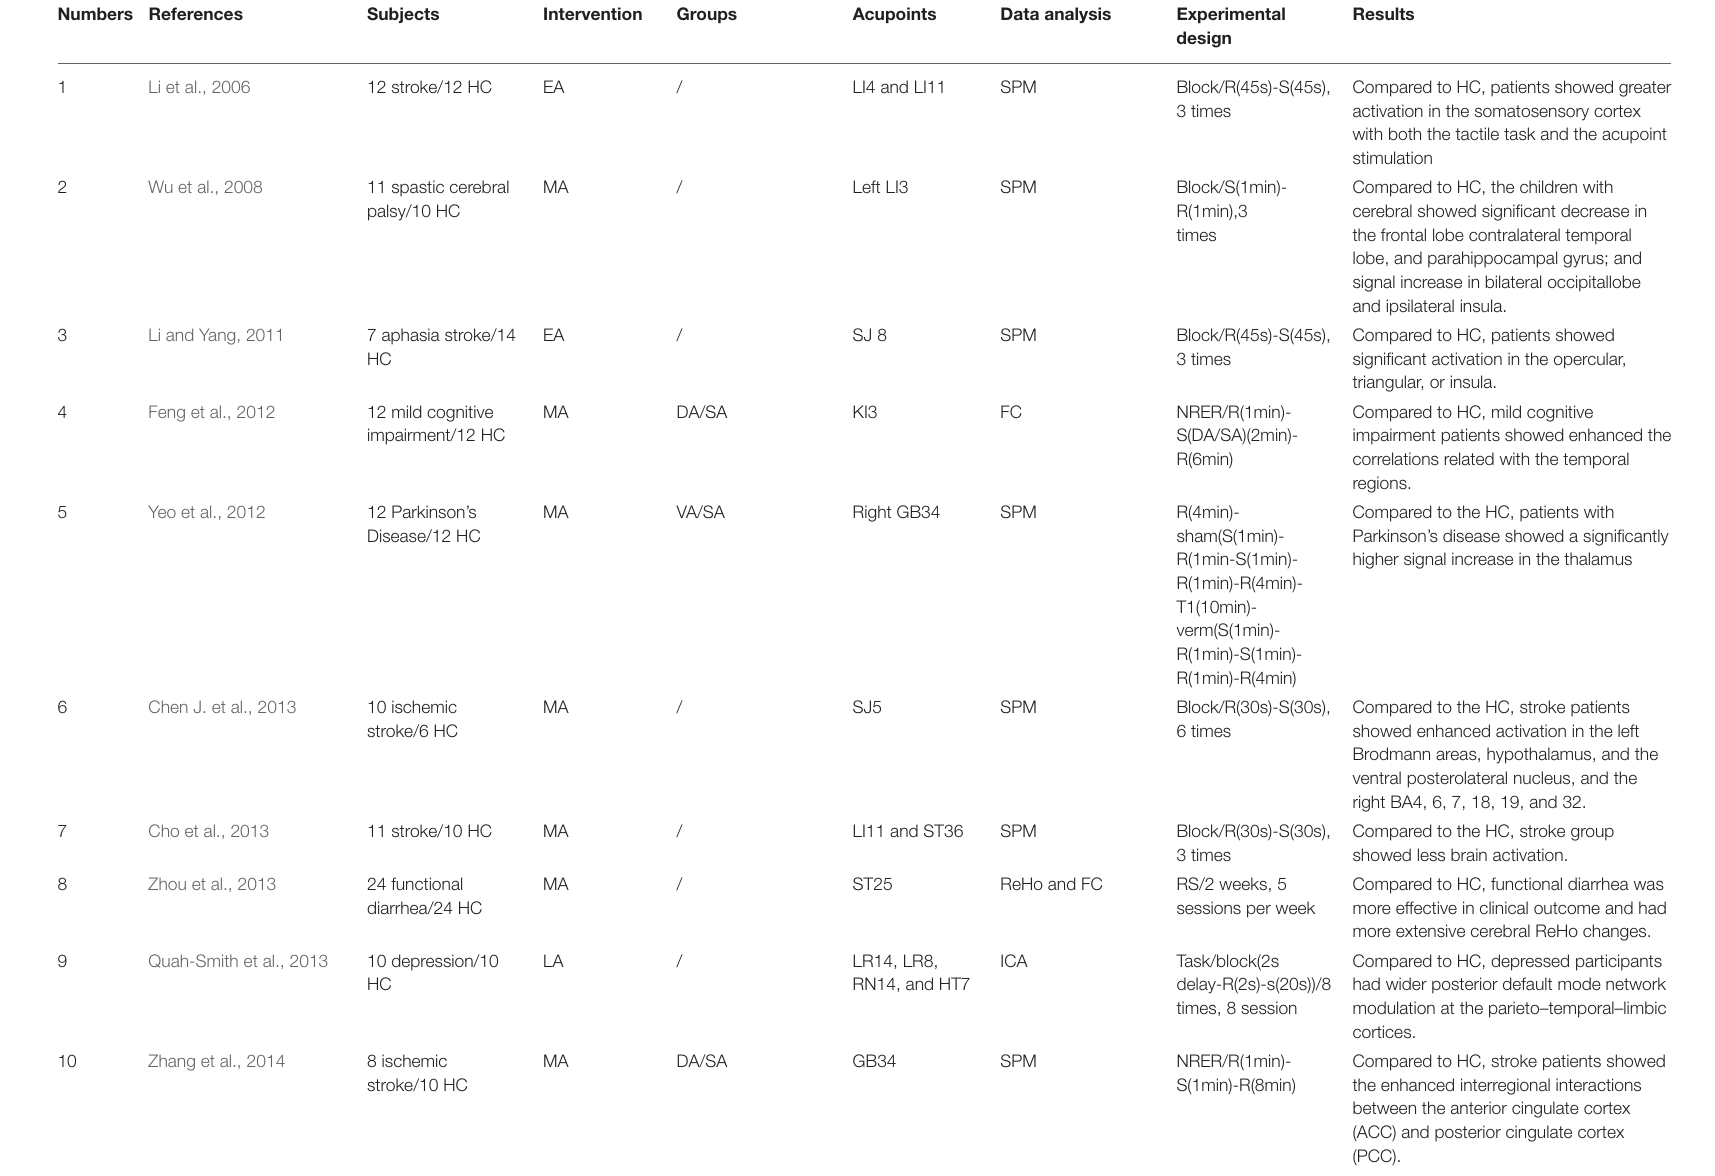
TABLE 2 | Characteristics of studies about patients and